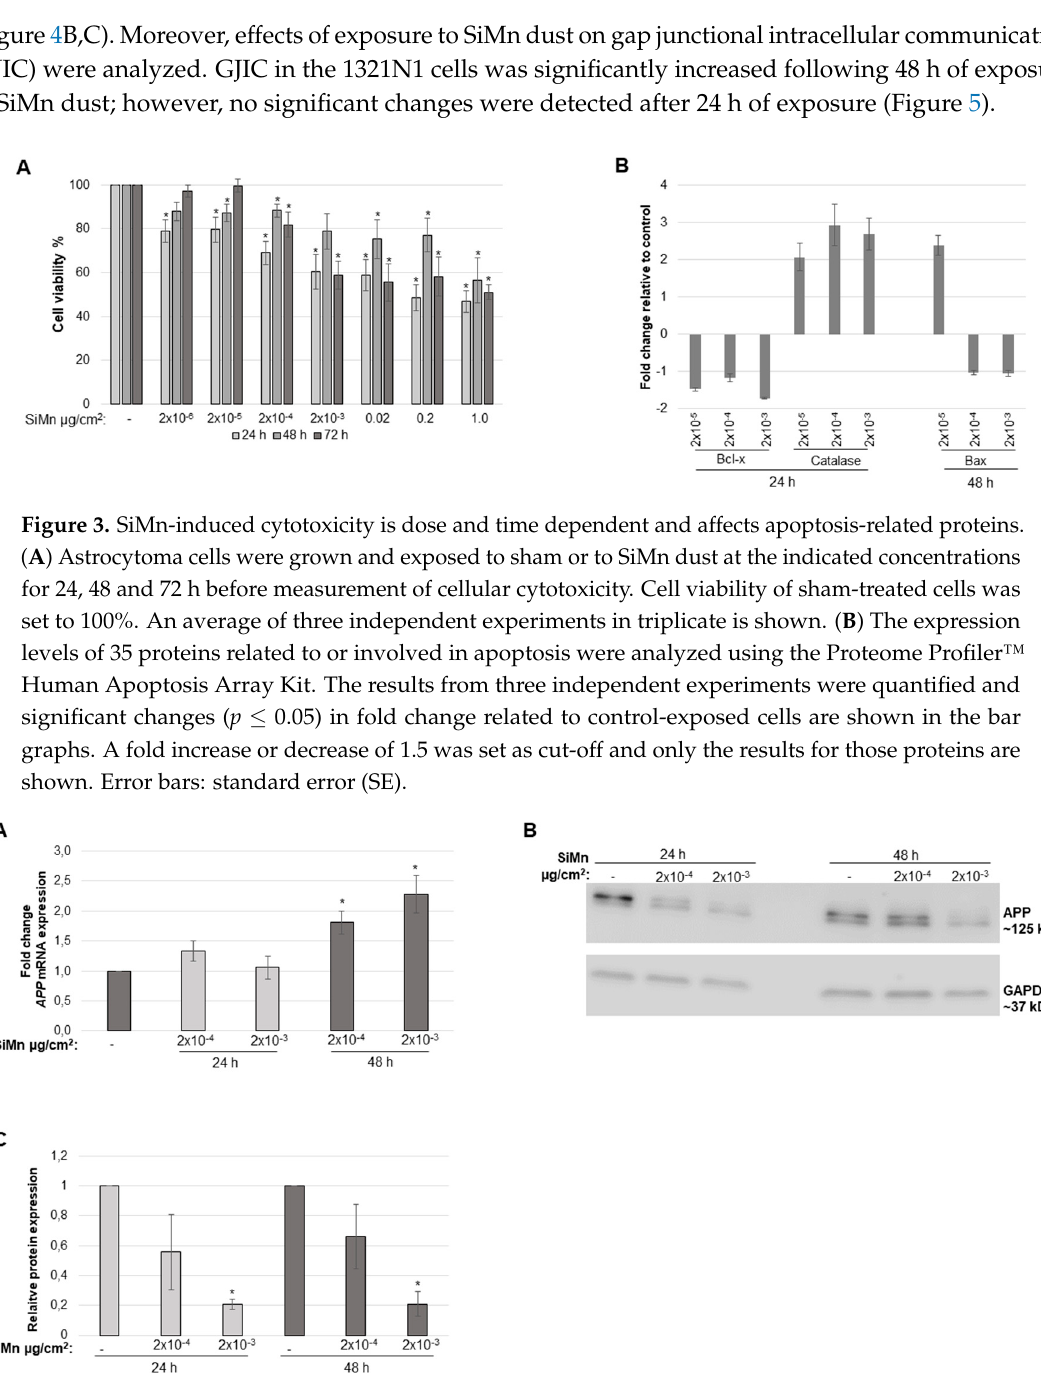
Figure 4. Expression levels of APP after exposure to SiMn. Astrocytoma cells were exposed to SiMn for 24 and 48 h with the indicated doses. mRNA expression was investigated by qPCR. ( A ) APP mRNA expression levels. An average from three independent experiments in triplicate is shown. ( B ) APP protein expression levels. Representative western blot images are shown. ( C ) Quantification of APP protein expression. An average from three independent experiments is shown. Values represent the mean ± standard error (SE). * p ≤ 0.05 between exposed cells and the sham-treated control. Error bars: SE.